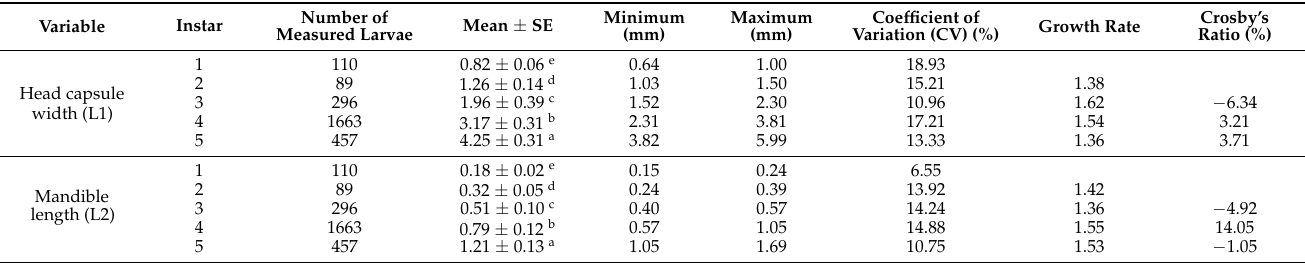
Figure 2. Frequency distribution of the variables separating larval instars of M. saltuarius. ( a ) head capsule width, ( b ) mandible length, ( c ) distance between the main ocelli, ( d ) prothoracic plate width, ( e ) mesothoracic spiracle length, ( f ) body width, ( g ) body length. Table 2. Measurements and analyses of seven variables of different larval instars of Monochamus saltuarius